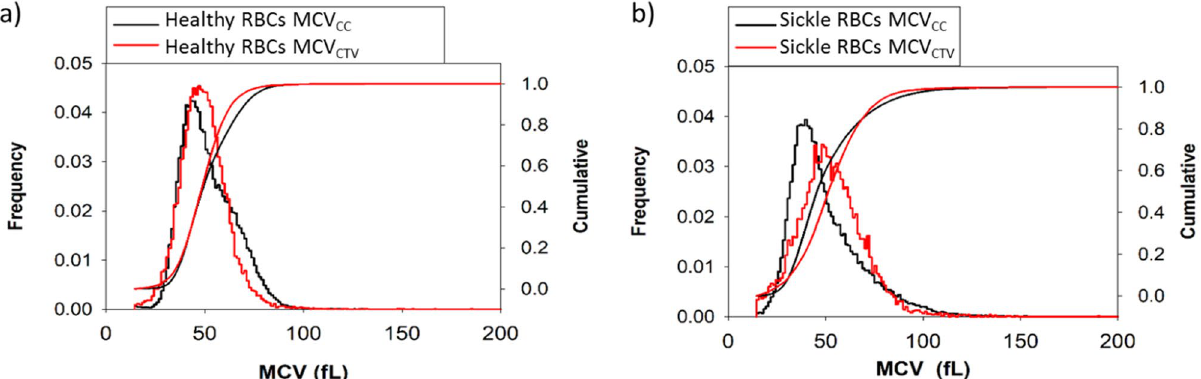
Figure 4. Volume histogram distribution (left y-axis) and cumulative curve (right y-axis) of RBCs measured on Coulter Counter (black) and CTV (red) for ( a ) all 31 healthy RBC samples and ( b ) all 15 sickle RBC samples.